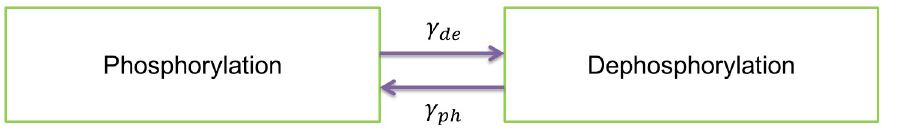
Fig 8. NFs kinetics between states of phosphorylation and dephosphorylation.